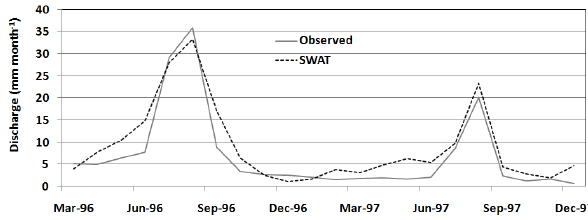
Fig. 5. Monthly observed and predicted discharge at the Jemma